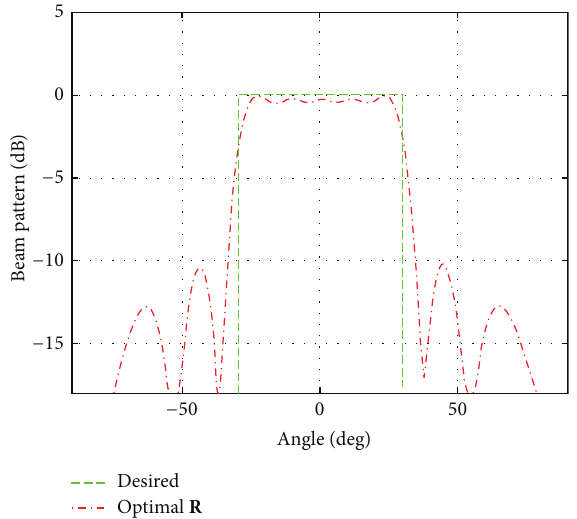
Figure 3: Beam pattern of covariance matrix R calculated by SEDUMI tool.